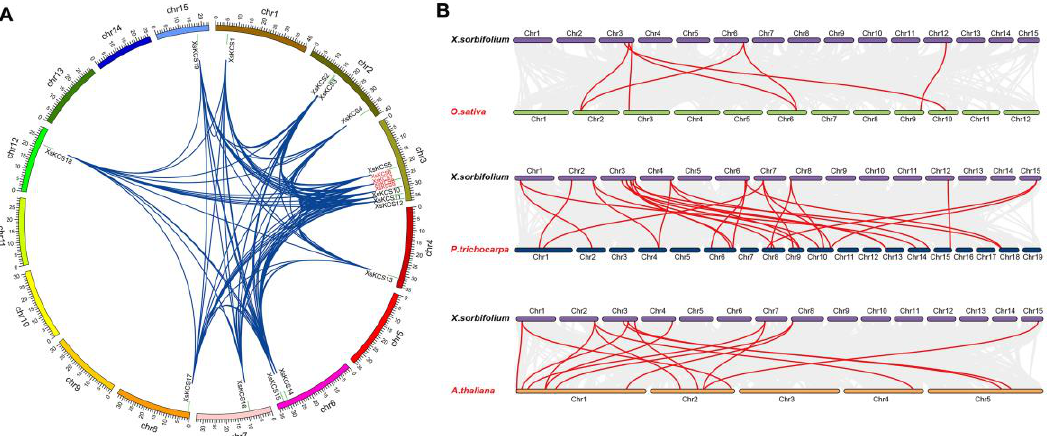
Figure 4. Chromosomal distributions, synteny analysis within the yellow horn and between yellow horn and three representative plant species. ( A ) The chromosome distribution and chromosome relationship of the yellow horn XsKCS genes. The blue lines indicate the repeated pairs of XsKCS genes, and the red letters represent tandem repeats. ( B ) Synteny analysis between yellow horn ( X.sorbifolium ) and three representative plant species, O.sativa , P.trichocarpa and A.thaliana . The grey lines are indicative to the collinear blocks within yellow horn and other plants; the red lines refer to the syntenic XsKCS gene pairs.